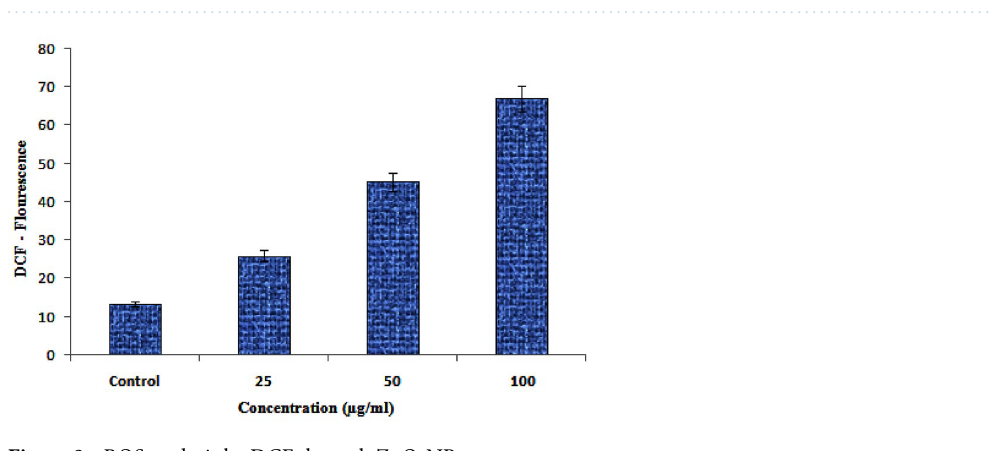
Figure 9. ROS analysis by DCF through